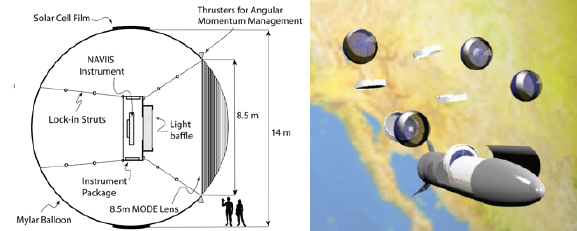
Fig. 2. A unit Nautilus telescope is launched in a compact configuration and inflated in orbit (left). Due to the compact launch configuration, multiple Nautilus units could be launched simultaneously in next-generation rocket fairings (right). [3, 4]